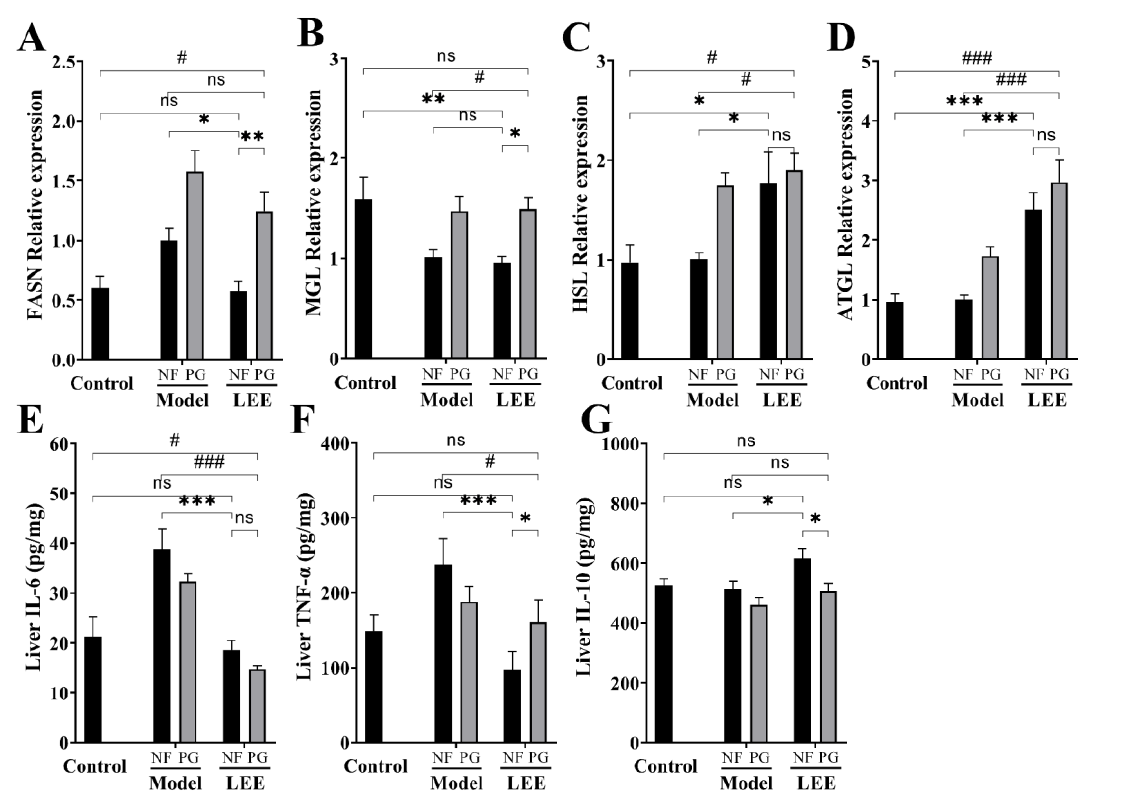
Figure 7. LEE administration improves HFD-induced lipid metabolism-related gene mRNA abnormal expression and inflammation in mice. Relative mRNA expression of FASN ( A ), MGL ( B ), HSL ( C ), and ATGL ( D ). Liver IL-6 ( E ), TNF- α ( F ), and IL-10 ( G ) contents. Data are expressed as the mean ± SEM (n = 6). * p < 0.05; ** p < 0.01; *** p < 0.001; # p < 0.05; ### p < 0.001; ns, not significant.